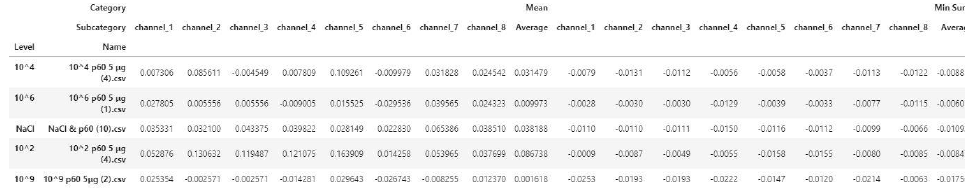
Figure 4. Feature vectors for five random samples (10 2 , 10 4 , 10 6 , 10 9 , and NaCl).